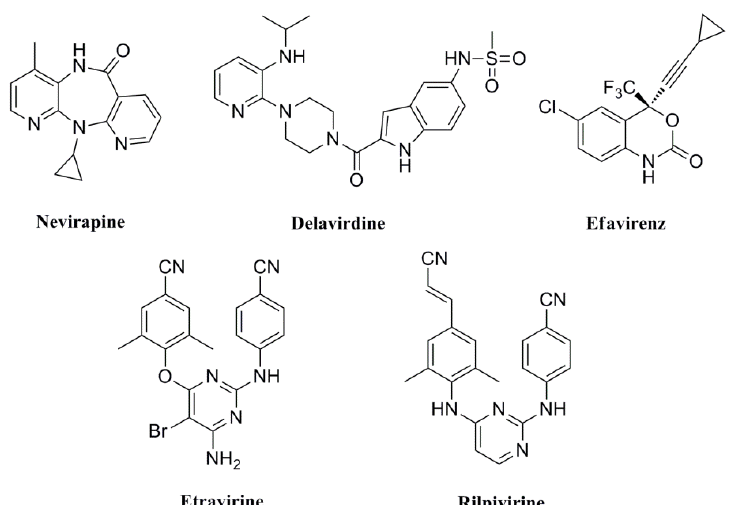
Figure 1. Structures of NNRTI